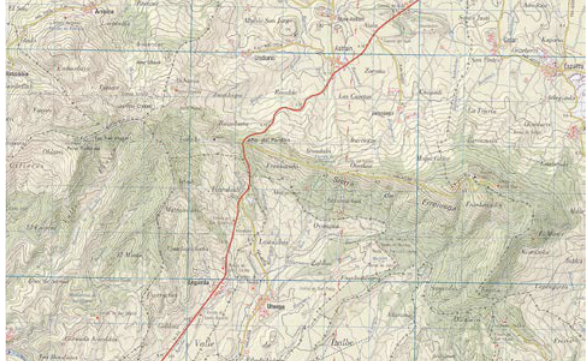
Table 2. Software and hardware platforms used in the research.